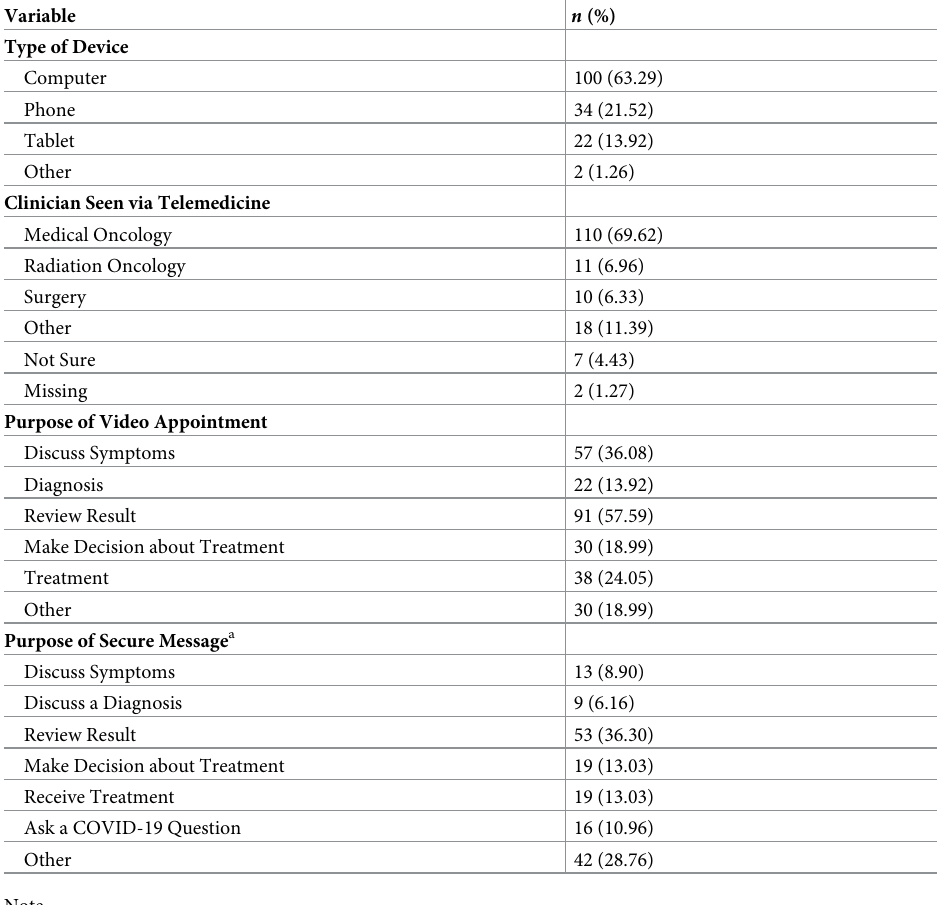
Table 2. Device, telemedicine type, and purpose of remote medical